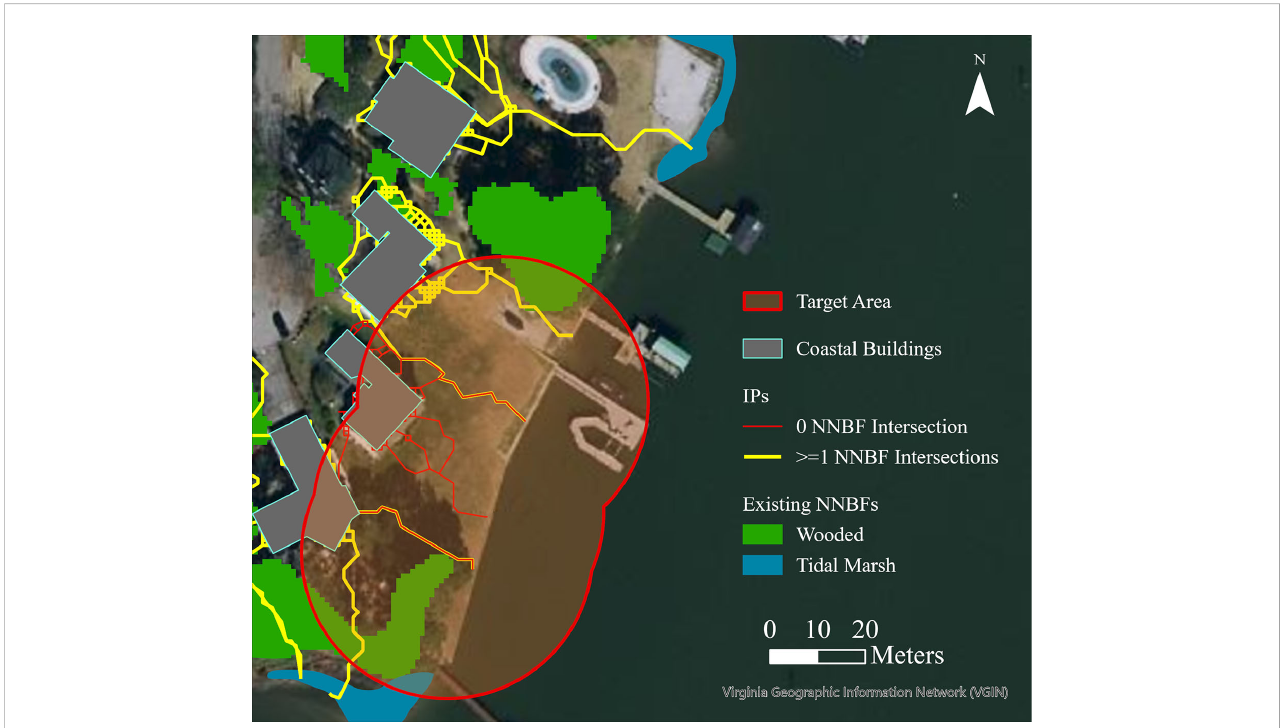
FIGURE 3 Target area in the Peninsula region that is centered on a building IP with zero intersecting NNBF, with existing adjacent tidal marsh and wooded NNBF. This target area has existing impervious surfaces and turf grass, is recommended for a non-structural living shoreline by the SMM, and structure enhancement suggestions include adding natural features to the existing bulkhead. (Imagery source: Virginia Geographic Information Network,